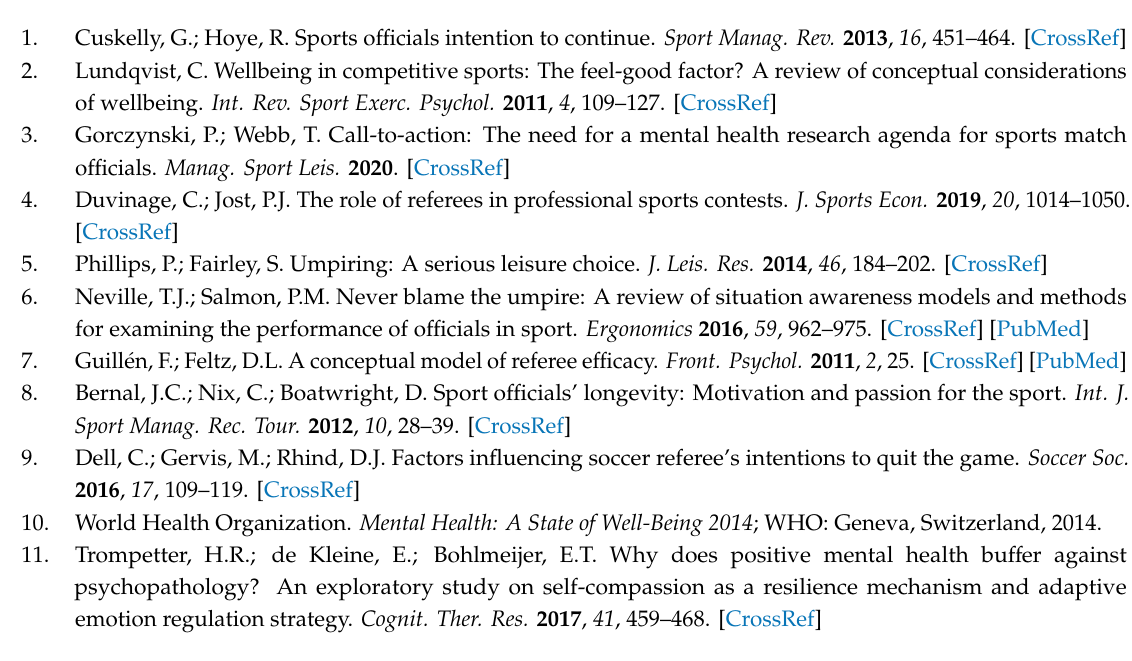
Table S1: Summary of study variables, measures and example survey